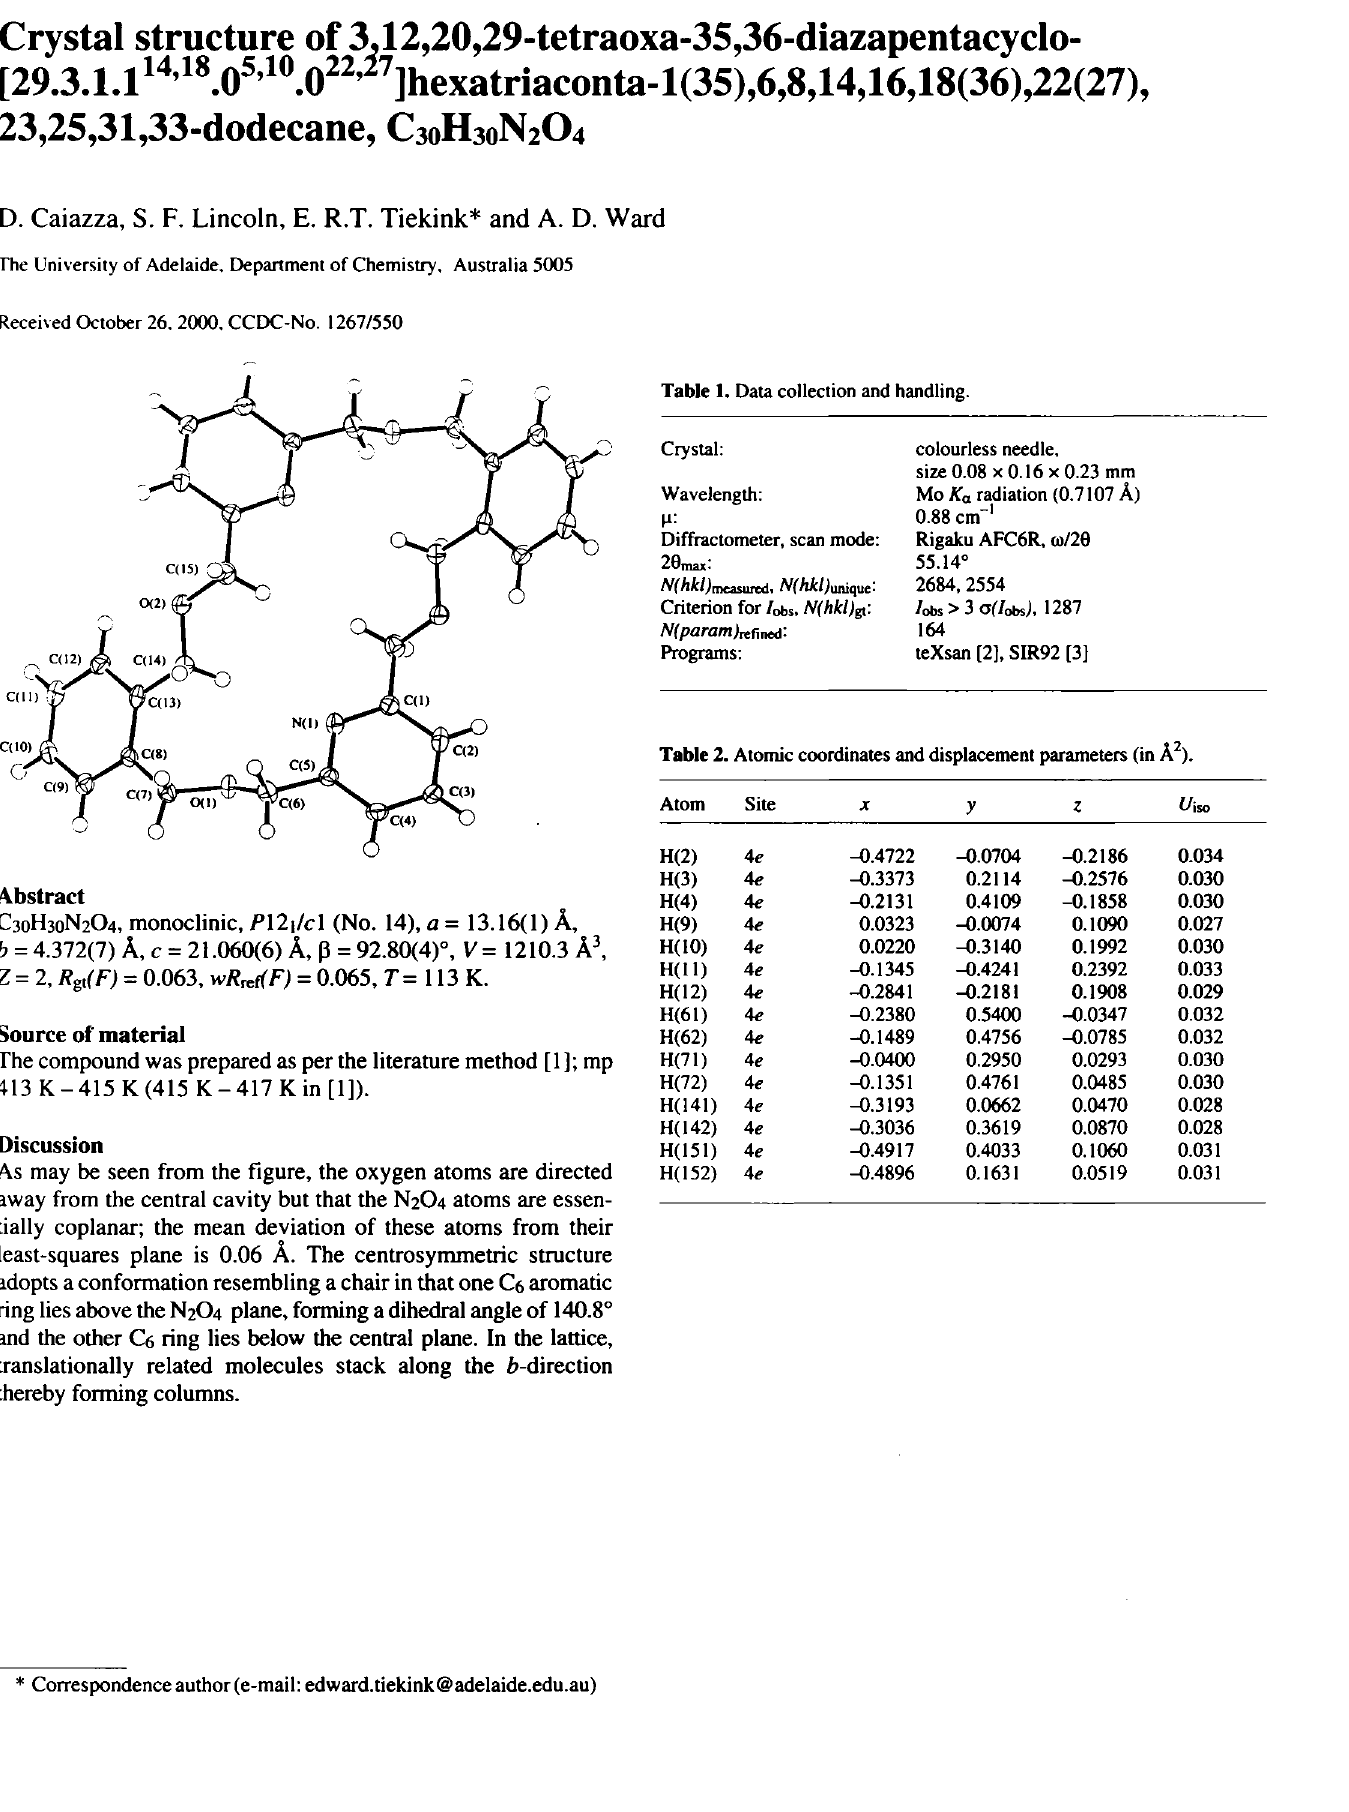
Table 2. Atomic coordinates and displacement parameters (in Ä 2